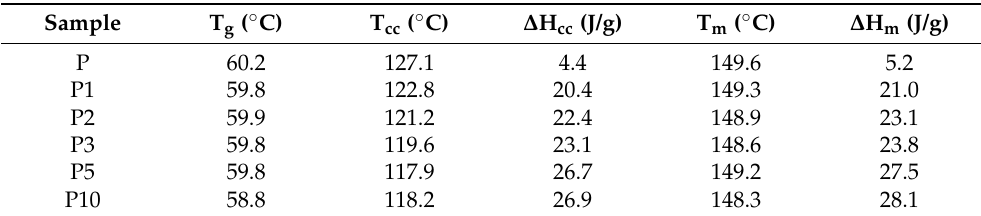
Table 2. Thermal properties of the tested